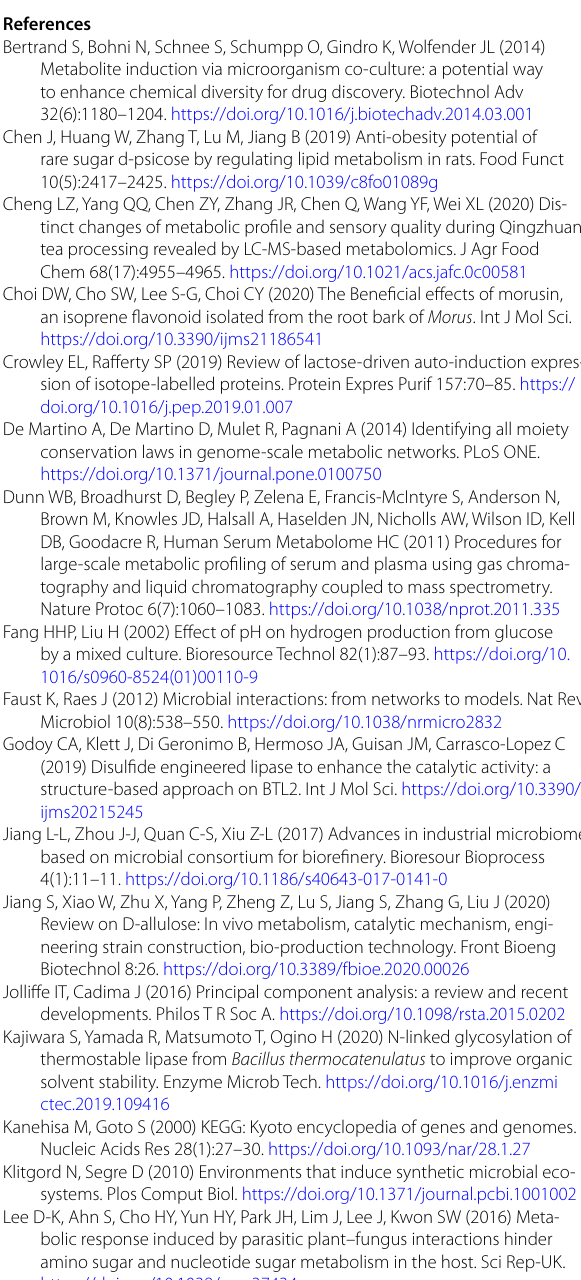
( b ), permutation test ( c ), and volcano plot ( d ) for group 4 vs 6 . Fig. S7. Heatmap of hierarchical cluster analysis for extracellular and intracellular differential metabolites. a extracellular differential metabolites between B. subtilis and mixed strains in; b intracellular differential metabolites between B. subtilis and mixed strains; c extracellular differential metabo- lites of E. coli and mixed strains; d intracellular differential metabolites of E. coli and mixed strains. Fig. S8. Radar char analysis for differential metabolites of group 1 vs 5 ( a ), 2 vs 6 ( b ), 3 vs 5 ( c ), and 4 vs 6 ( d ). Fig. S9. Correlation analysis for differential metabolites of group 1 vs 5 ( a ), 2 vs 6 ( b ), 3 vs 5 ( c ), and 4 vs 6 ( d ). Fig. S10. Network analysis for group 1 vs 5 ( a ), 2 vs 6 ( b ), 3 vs 5 ( c ), and 4 vs 6 ( d